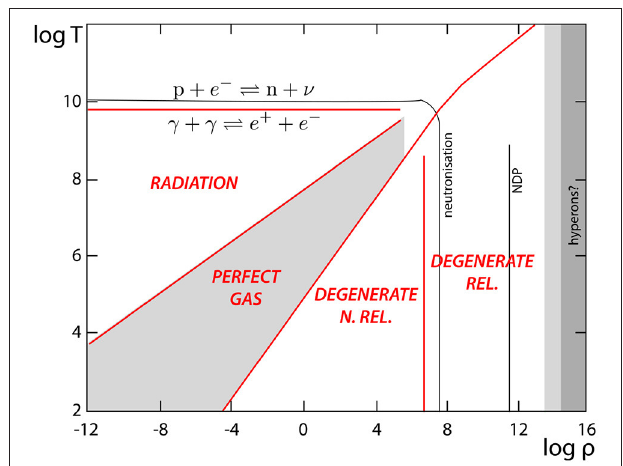
FIGURE 1 | T vs. ρ diagram showing the different regimes of the state of